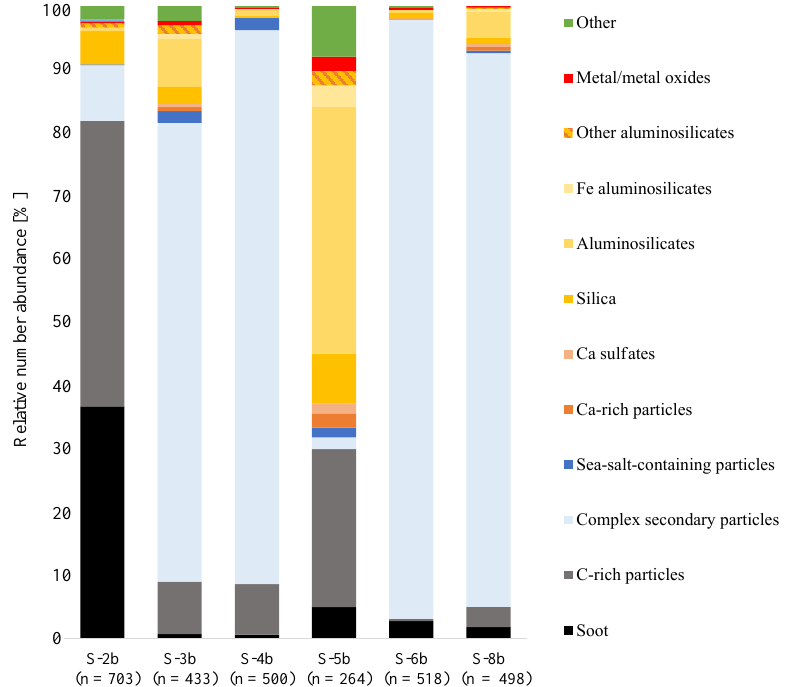
Figure 4. Relative number abundance of the different particle groups within total aerosol samples. Sample S-2b shows a combustion event with air mass history from the Po Valley, and sample S-5b is influenced by an analytical artefact from particle loss of volatile particles.